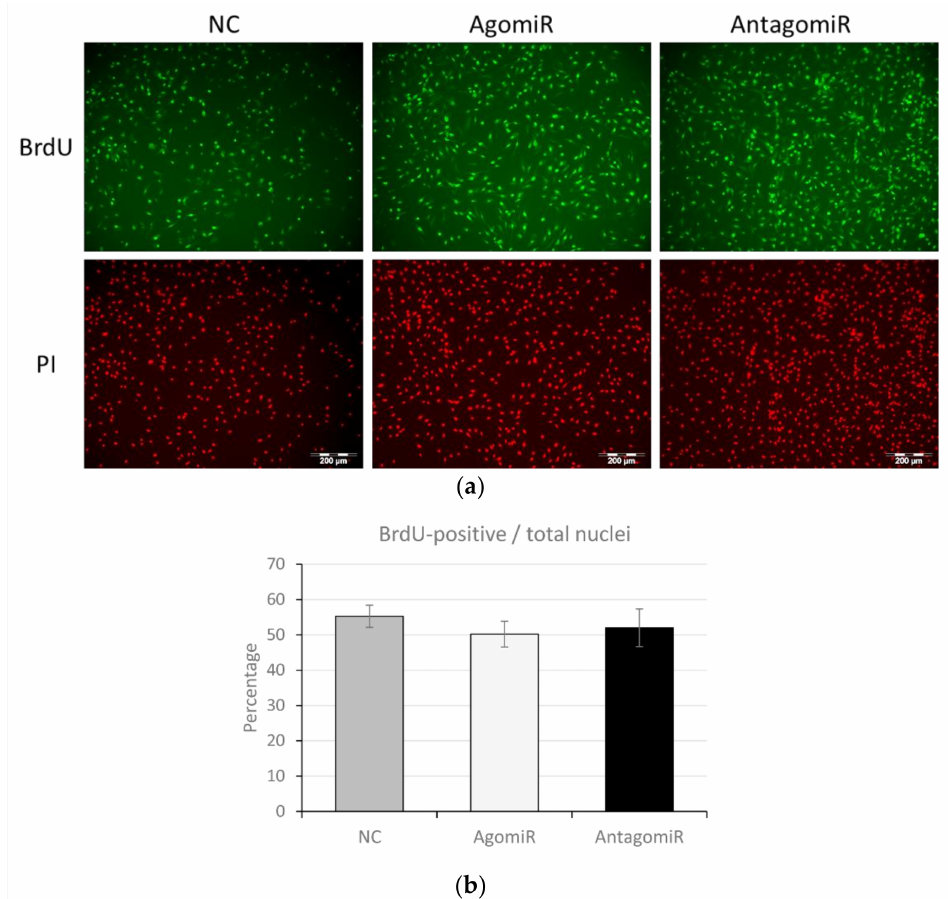
Figure 5. Impact of altered miR-100 levels on bovine muscle satellite cell proliferation. ( a ) Immuno- cytochemical detection of BrdU incorporated in nuclei of proliferating cells (green) and total nuclei stained with propidium iodide (PI, red) in cells treated with agomiR and antagomiR. Scale bar represents 200 µ m. ( b ) The percentage of BrdU positive nuclei normalized to total nuclei in the well in presence of agomiR and antagomiR compared to negative control (NC). Data is representative of three independent experimental replicates per sample